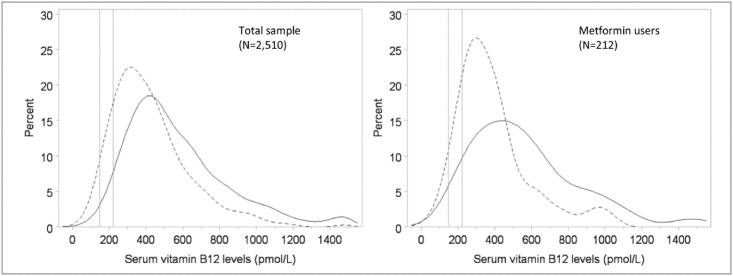
Distribution of serum vitamin B12 concentrations by multivitamin use—REasons for Geographic And Racial Differences in Stroke, 2003–2007.Dotted line represents the distribution of B12 concentrations for non-multivitamin users; Vertical line at 148 pmol/L and 221 pmol/L represent the cutoffs for low vitamin B12 concentration, and borderline B12 concentration, respectively.